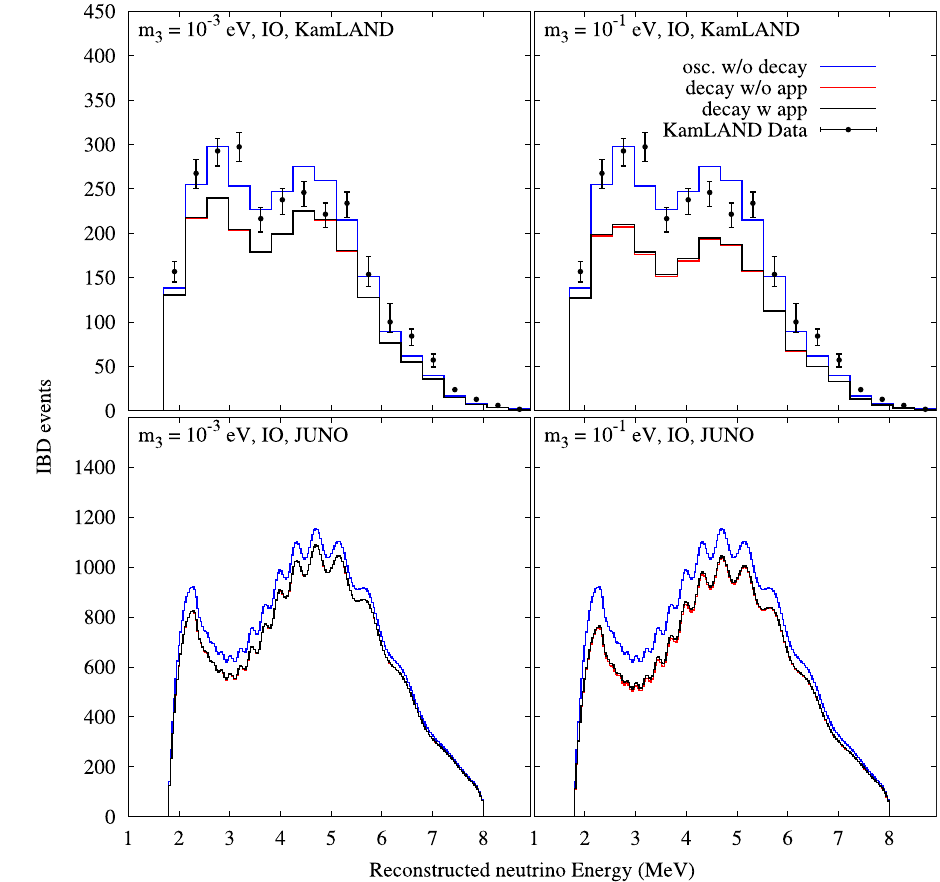
(cid:12) two different values of lightest neutrino mass lead to m 2 2 = 2 . 40 × 10 − 3 eV 2 for m = 10 − 3 eV, and (cid:7) m 2 lightest atm (cid:12) m 2 = 10 − 2 eV 2 for m = 10 − 1 eV. As a m 2 lightest 2 lightest result, the decay width is an order of magnitude larger in the case of m lightest = 10 − 1 eV, leading to the small but visi- ble difference between the left and right panels for the IO in Fig. 2. In the NO, the situation is similar but m lightest depen- dence is not visible in Fig. 3 because the impact of decay itself is small due to small value of θ 13 as explained in the end of Sect. 3. We must remind the readers that these